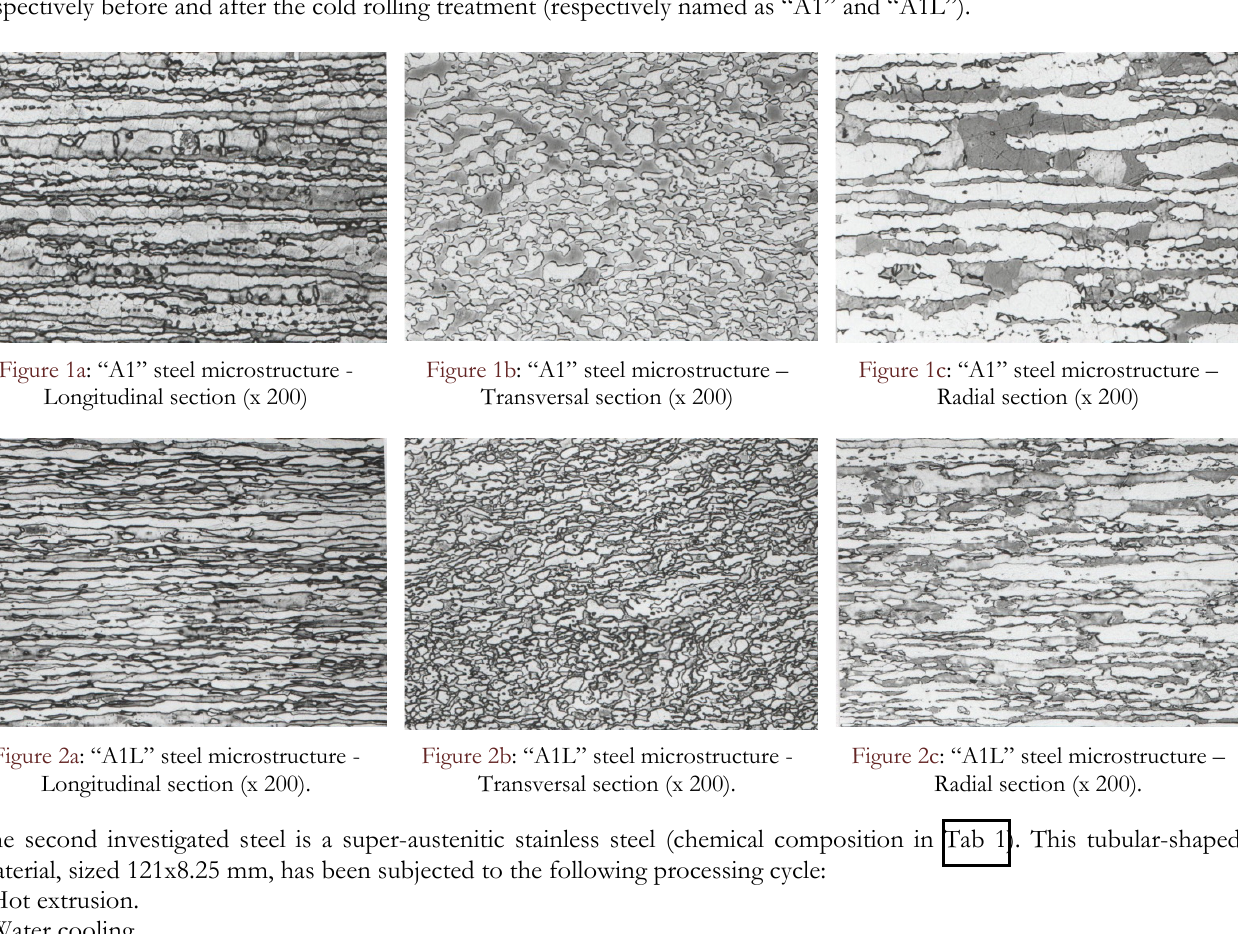
Figure 2c: “A1L” steel microstructure – Radial section (x